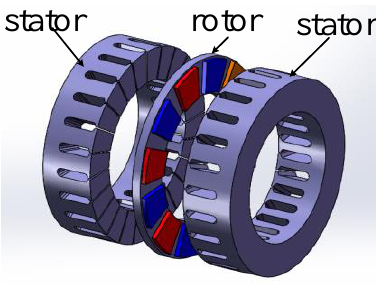
Figure 1. Three-dimensional structure of double stator-single rotor axial flux permanent magnet synchronous motor (AFPMSM).